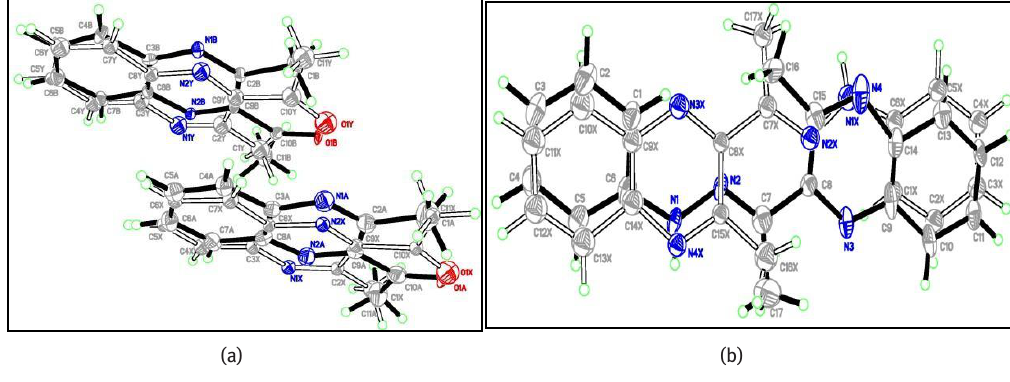
they show deep blue fluorescence including bathochromic shift (λ max ) respectively. The intensity of the blue fluorescence gradually decreases with increasing the polarity of the solvents (moderately polar aprotic). We also observed the compound 29 has similar emission spectra in CHCl 3 , CH 2 Cl 2 and THF whereas the compound 33 gives different emission spectra with decreasing λ max from CHCl 3 to THF. Now among the polar aprotic solvents, acetone, DMF and CH 3 CN show the almost similar emission spectra (yellow fluorescence) but DMSO and ethyl acetate give a blue-shifted spectra of compound 29 (Fig. 19 ). Figure 17: Molecular view of compounds (a) 31 and (b) 32 (adapted from ref. 57). The crystal packing of the major component for compounds (a) 31 and (b) 32 , viewed along the (a) b-axis and (b) a-axis.